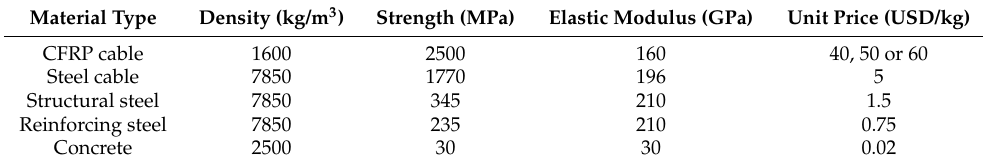
Table 2. Material